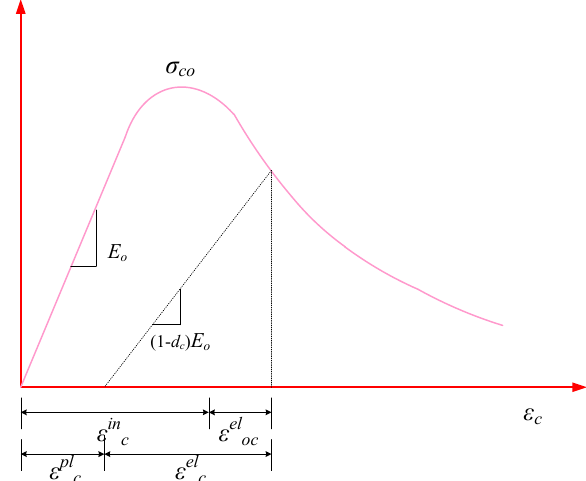
Figure 5. Stress-strain efficiency of HFRGC under compression.